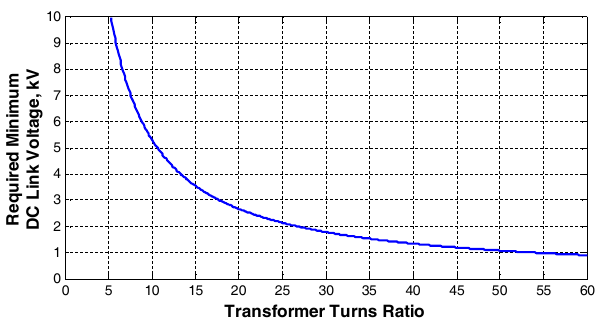
Figure 9. Minimum DC link voltages required for various transformer turns ratios.